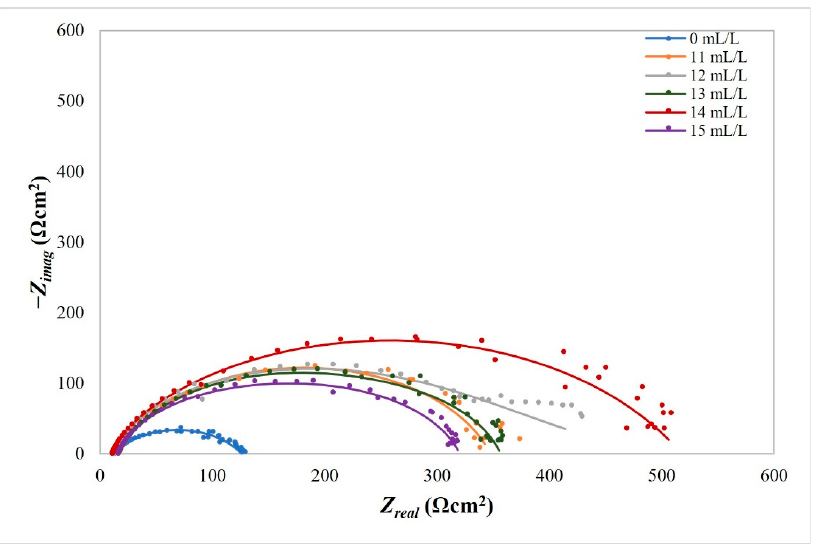
Figure 7. Nyquist plot scanned on the carbon ‐ steel sample in the simulated brine saturated with CO 2 with and without the inhibitor in flow conditions (Adapted from [24]).